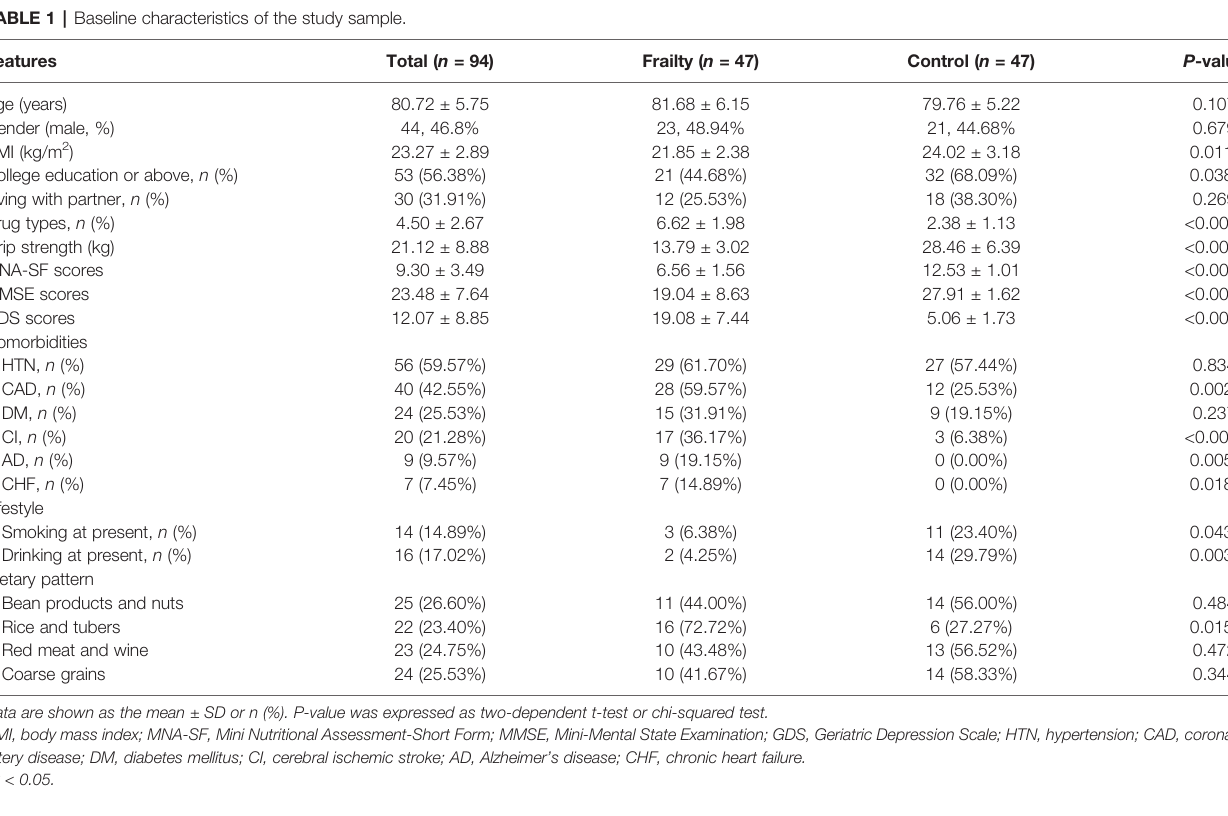
TABLE 1 | Baseline characteristics of the study sample. Features